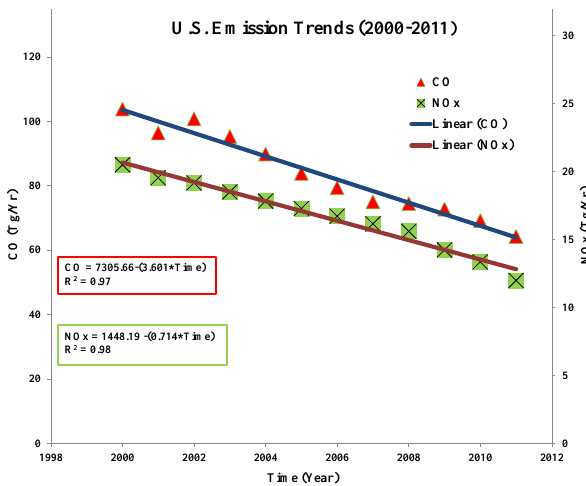
Fig. 1. US anthropogenic emissions (in Tgyr − 1 ) for CO and NO x from 2000 to 2011 (data available at: http://www.epa.gov/ttnchie1/